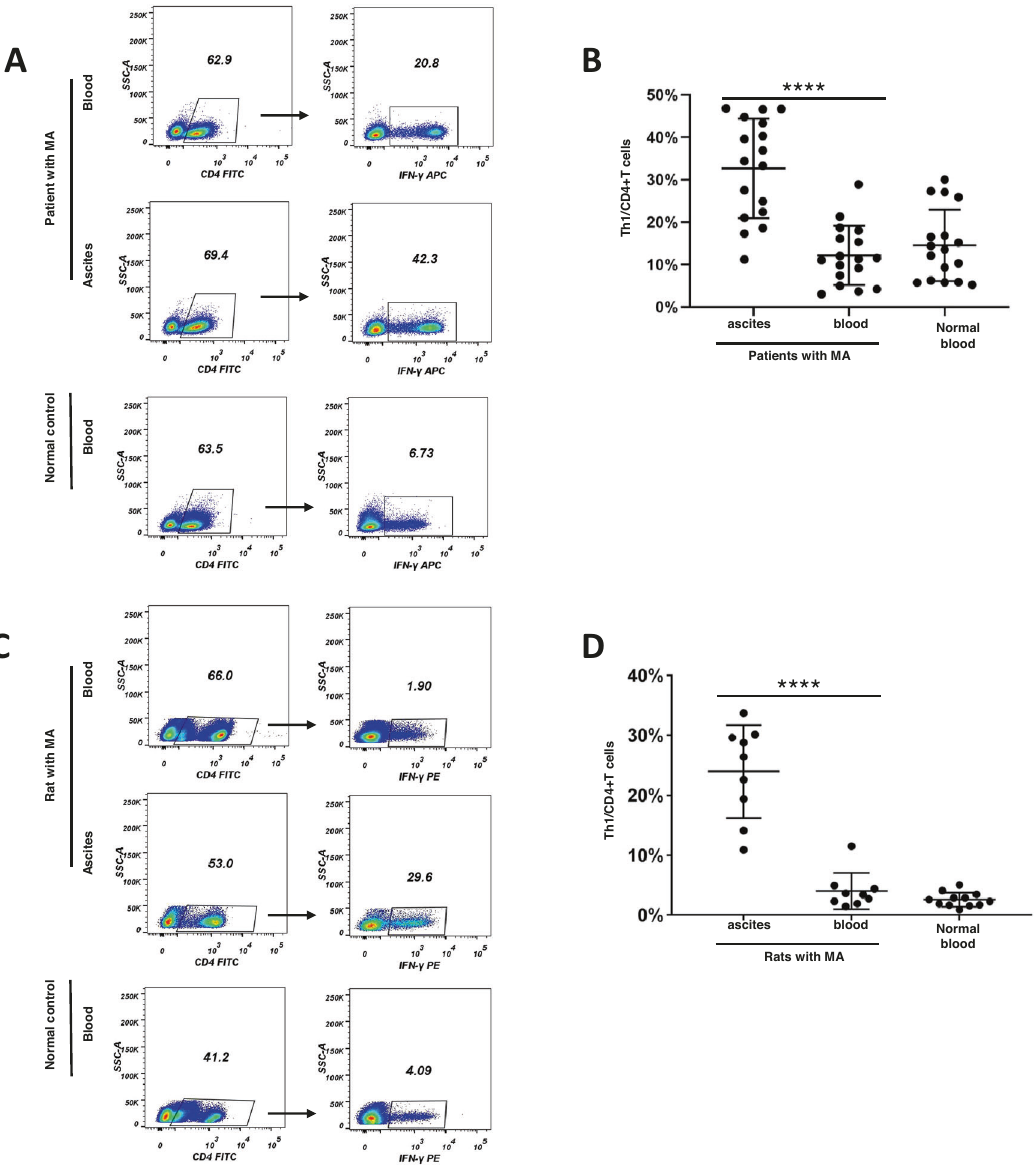
Fig. 1 Th1 cells in human and rat malignant ascites. A Representative dot plots from a patient with malignant ascites (MA) and a healthy control showing fl ow cytometric analysis of Th1 (IFN- γ + CD4 + ) cells; B the percentages of Th1 cells in peritoneal fl uid, peripheral blood in patients with malignant ascites. The difference between two groups was determined by t test; C representative fl ow cytometric dot plots of Th1 cells from a rat with malignant ascites at 21 days after intraperitoneal injection of Walker-256 cells; D the percentages of Th1 cells in peritoneal fl uid, peripheral blood in rat model of malignant ascites. The difference between two groups was analyzed by t test. **** p ≤ 0.0001. Th17 cells (CD4 + IL-17 + ) were observed in malignant ascites compared with the corresponding blood (Fig. 1A, B and Fig. S1 and S2). Simultaneously, the results showed no signi fi cant differences in the percentage of Th2 cells (CD4 + IL-4 + ) between peritoneal fl uid and corresponding blood (Fig. S3). Secondly,